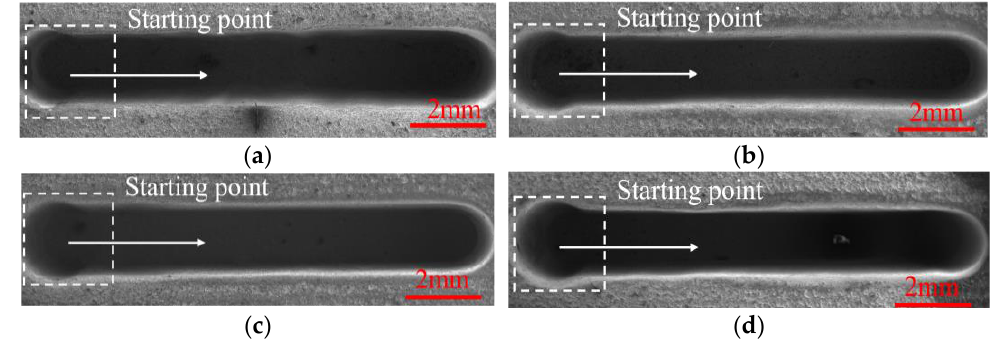
Figure 15. The SEM images of DNGs generated with varied feed rates. ( a ) Feed rate = 0.30 mm/min; ( b ) Feed rate = 0.36 mm/min; ( c ) Feed rate = 0.42 mm/min; ( d ) Feed rate = 0.48 mm/min.